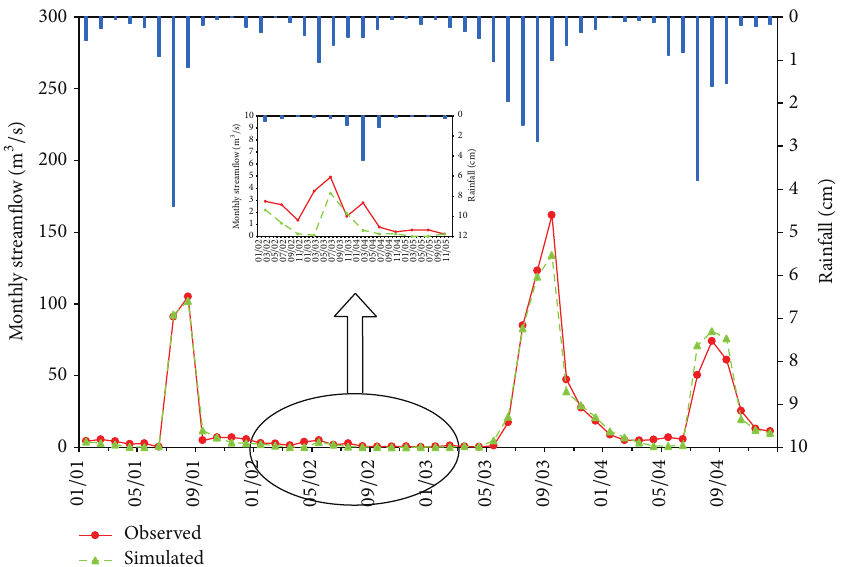
Figure 2: Comparison of observed and simulated results for mean monthly rainfall-runoff simulation in Jiaoyi watershed during calibration period (2001 ∼ 2004).